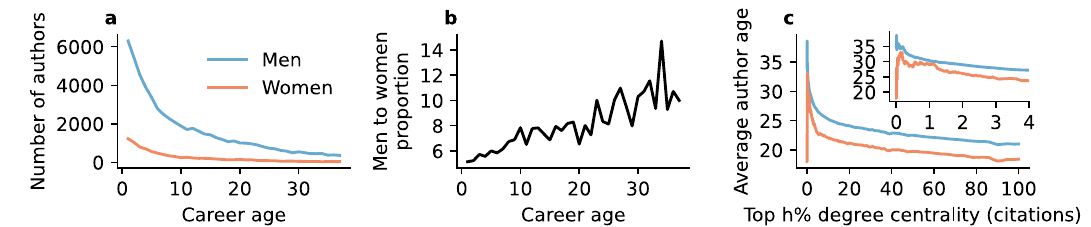
Fig. 4 Seniority distribution of researchers by gender. a Number of men and women authors by their career age. b Proportion of men to women by career age. c Average age of men and women authors of papers in each top h % of degree centrality (number of citations). The inset shows the same result zooming in on the higher